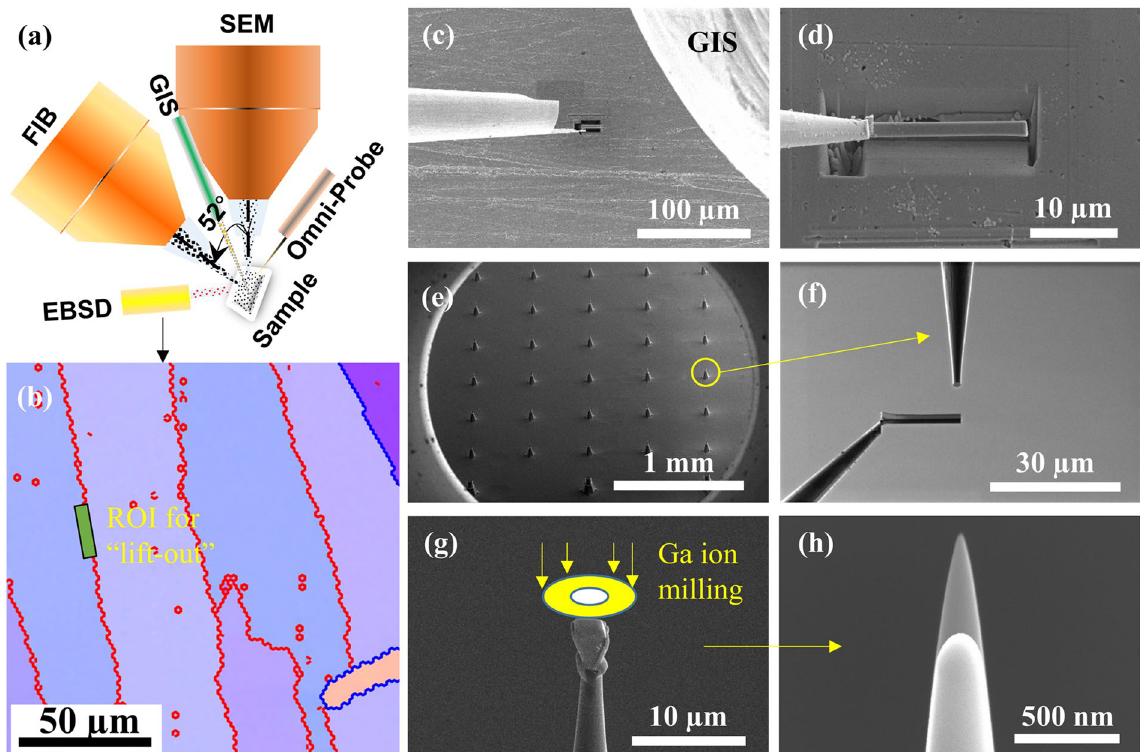
Figure 1. Site-specific “lift-out” process for preparing APT tips. ( a ) Schematic diagram of SEM-FIB dual beam system with EBSD attachment; ( b ) EBSD sample surface overlapped with grain boundaries. The green bar is the region of interest (ROI) for the “lift-out” process; ( c ) The micromanipulator (Omni-probe, left) and the gas injection system (GIS, right); ( d ) The Omni-probe and the ROI of sample are welded with Pt; ( e ) Microtip TM array coupon with 36 Si post; ( f ) Enlarged view of Si post and the sample before mounting on it; ( g ) One tip before suffering the Ga ion annular milling; ( h ) The APT tip profiles before (longer) and after (shorter) the measurement with tip radius of near 50 nm and 130 nm, respectively.